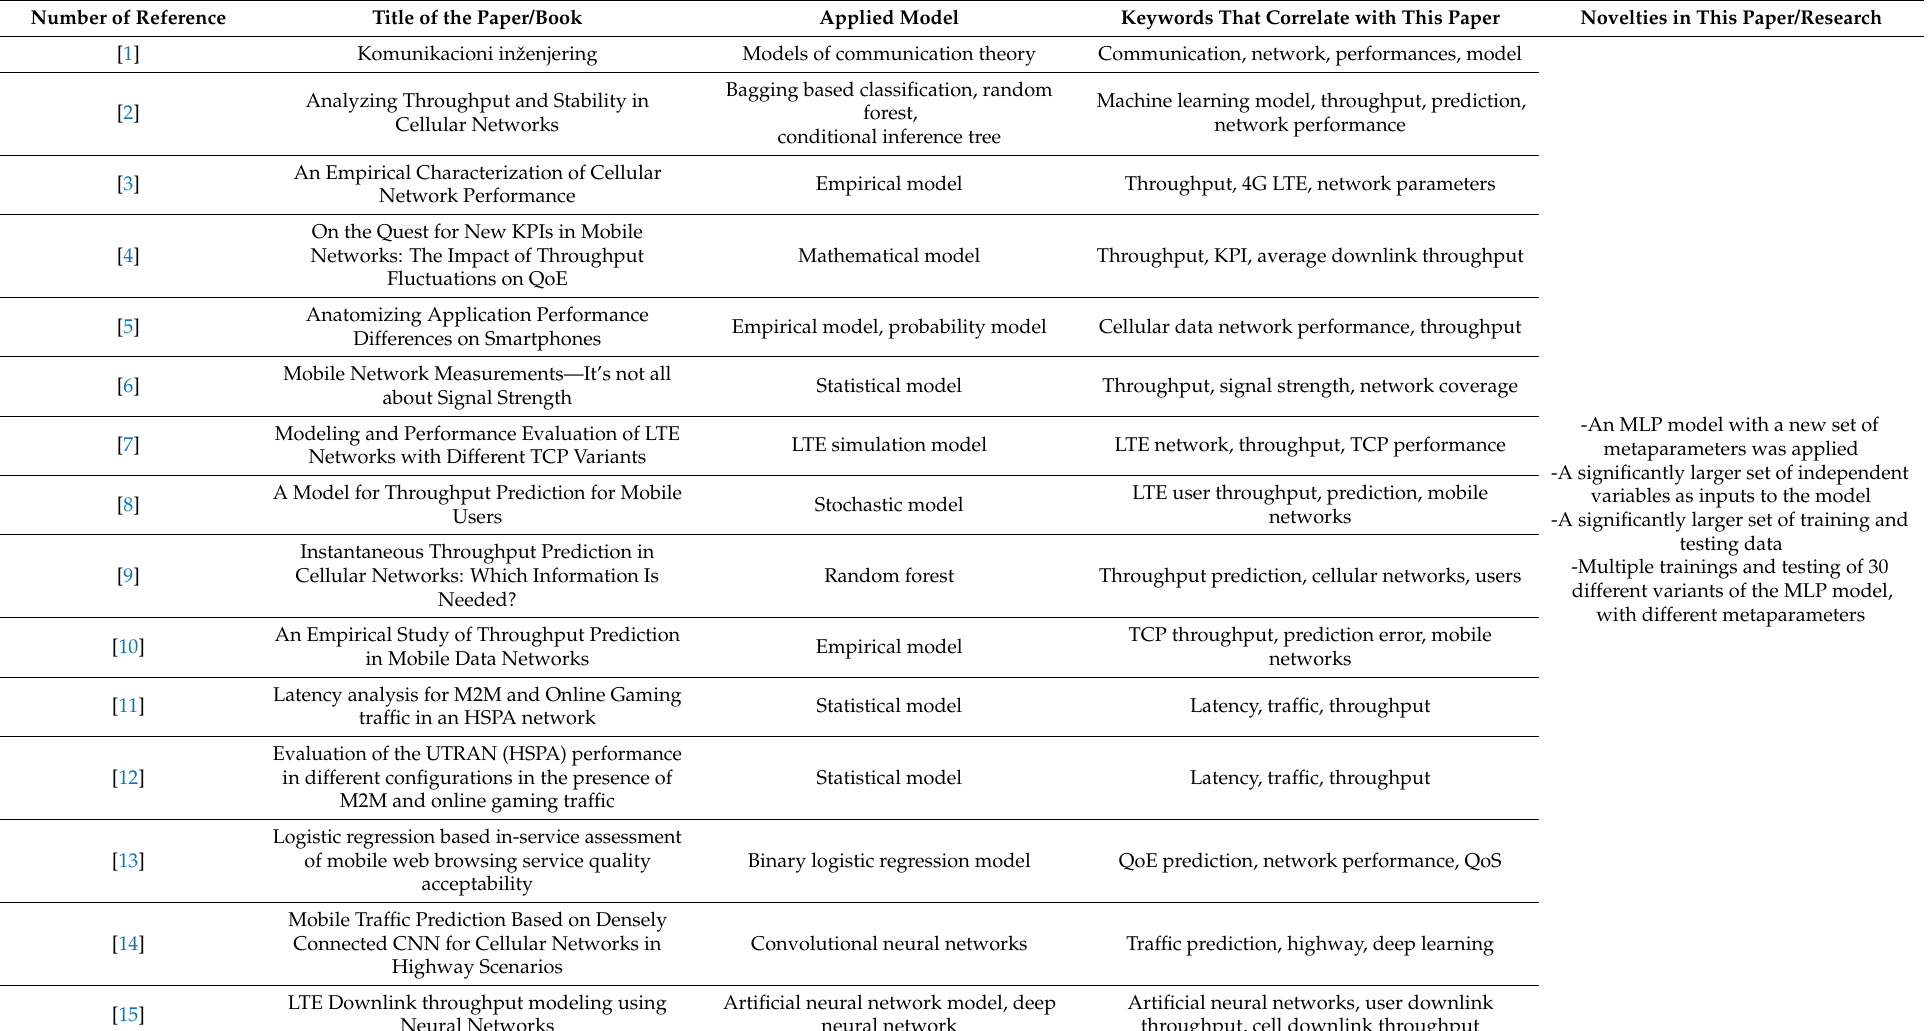
Table 1. Overview of referenced previous research in the subject of this